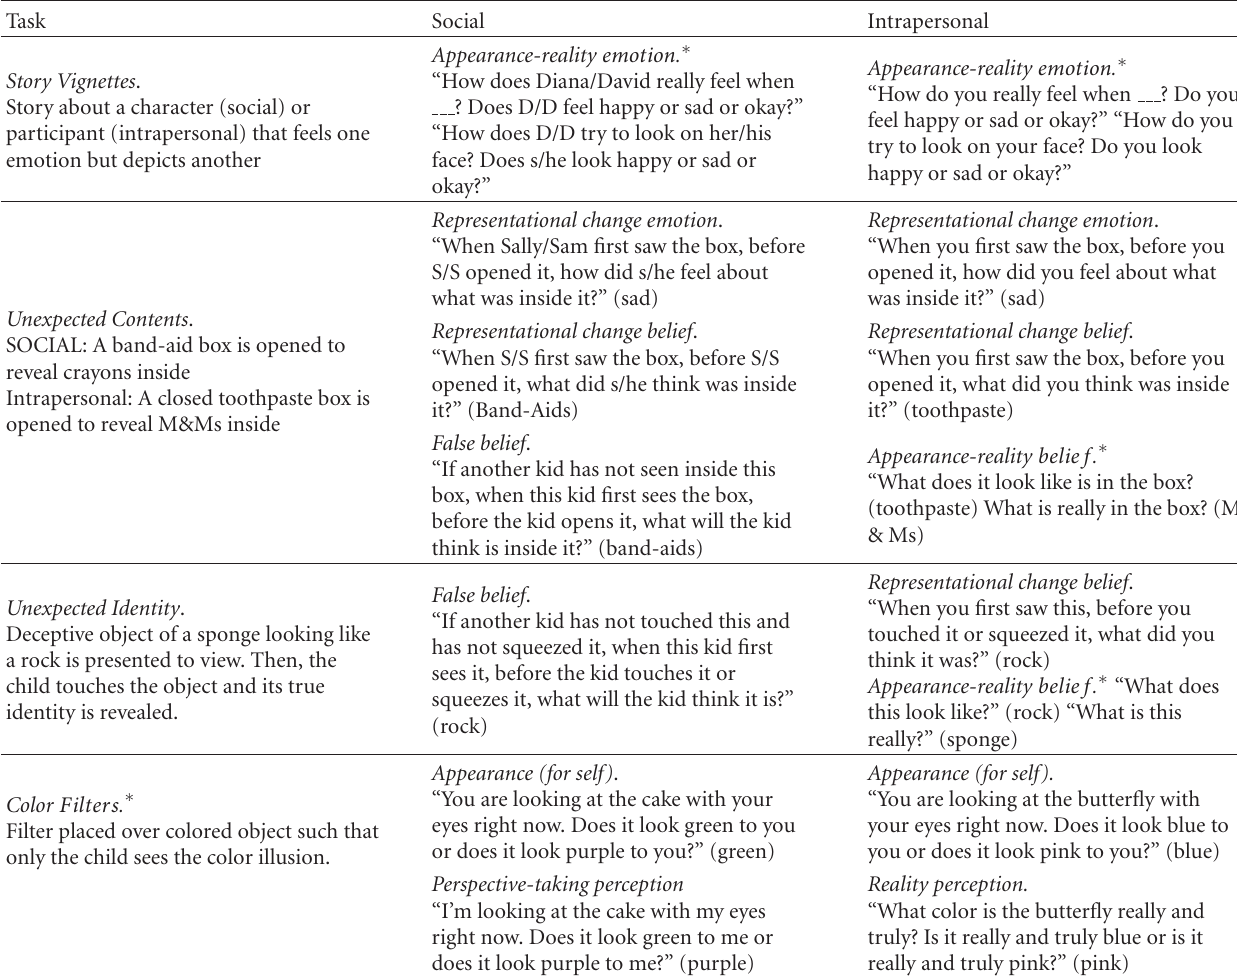
Table 2: Tasks and ToM behaviors by mental state